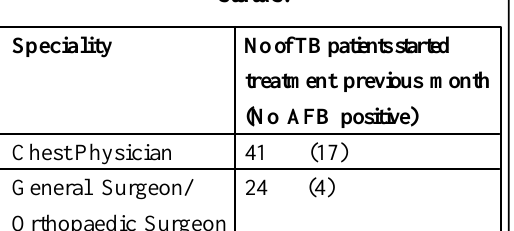
Number of patients who started treatment during the previous month by speciality and sputum status.